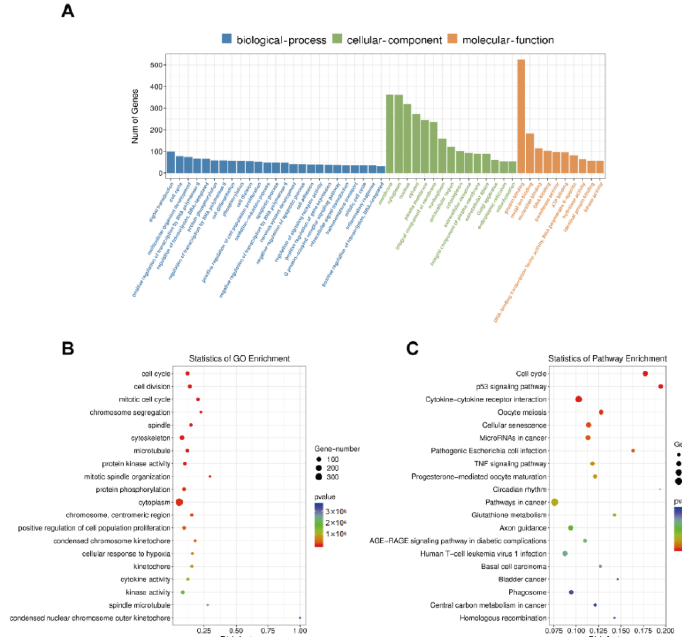
Figure 7. GO enrichment analysis and KEGG pathway analysis. ( A , B ) Biological processes, cellular components, and molecular functions were involved in the biological functions of GCTB stromal cells with Siglec ‐ 15 knockdown in GO enrichment analysis. ( C ) Twenty signaling pathways linked to cancer were shown by KEGG pathway analysis.